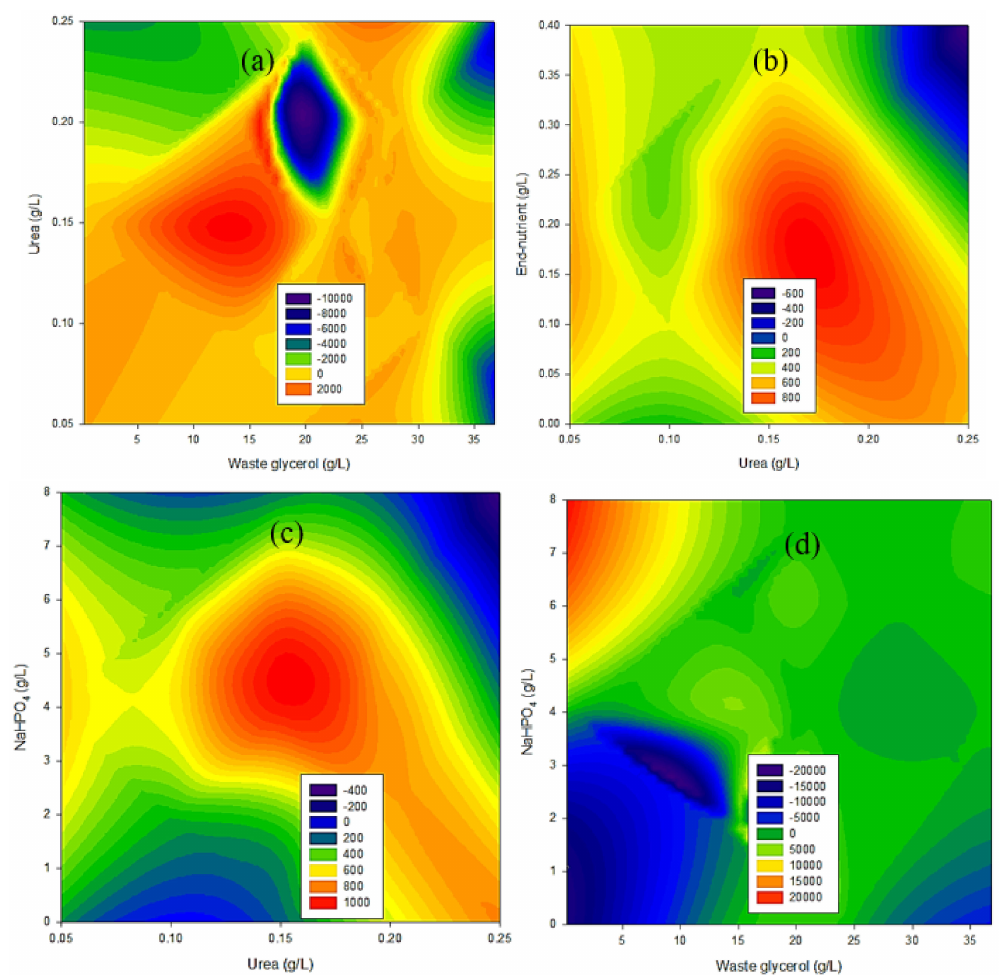
Figure 3. Contour plots showing the interaction between ( a ) urea and waste glycerol ( b ) Endo-nutrient and urea ( c ) Na 2 HPO 4 and urea ( d ) Na 2 HPO 4 and waste